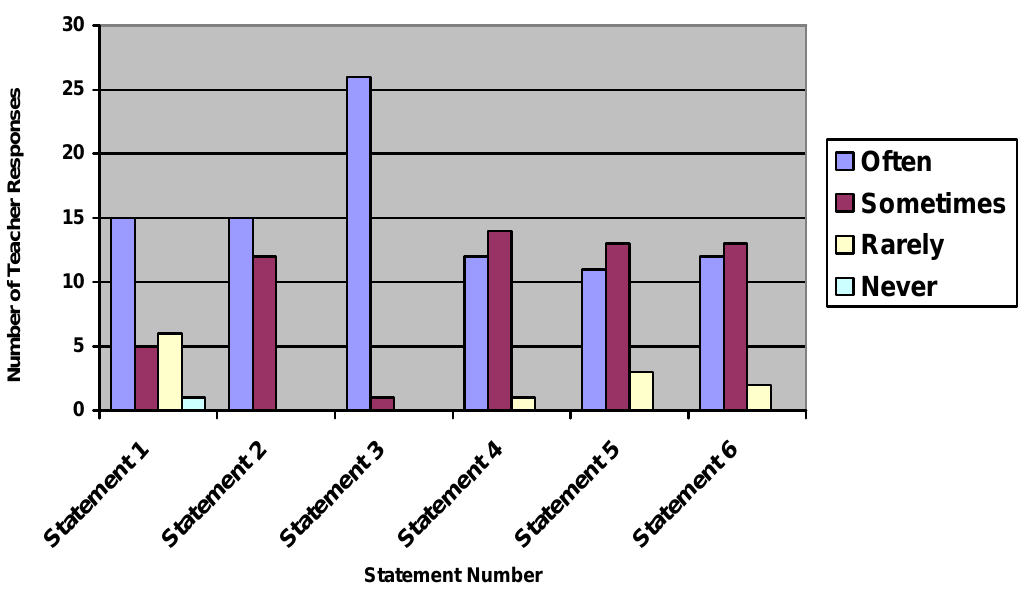
Figure 2. Teacher Survey from week one before implementation of posting and communicating daily learning